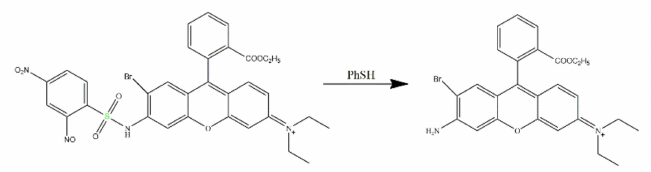
Figure 46. The proposed sensing mechanism of the prepared sensor (Table 3, No. 9) for PhSH [98]. Wang Z., et al. reported the rhodamine-based fluorescent sensor, named 6G-ClO (Table 3, No. 10), developed from 2-formyl rhodamine and used for ClO − detection in water and HUVEC cells [99]. Apart from the application in ClO − -detection in water and living cells, a test strip was prepared with 6G-ClO and successfully used for semi-quantitative detection of the same molecule (Figure 47).